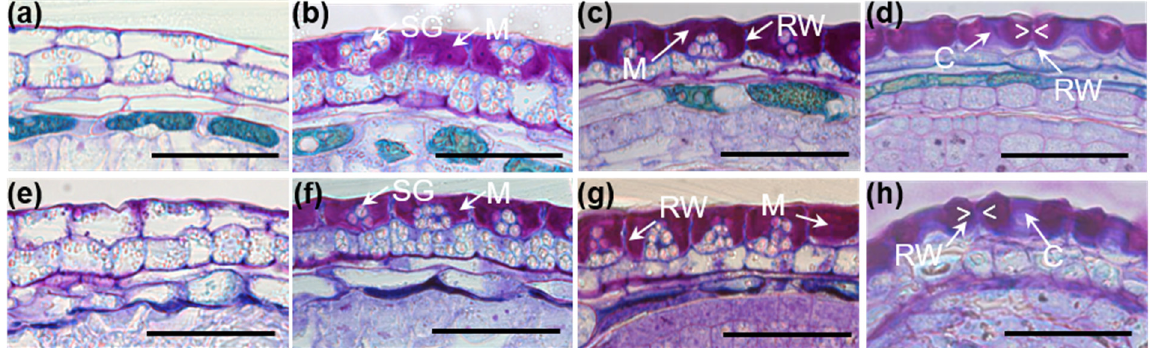
Figure 6. Differentiation of the outer seed coat is delayed in tt15-2 . Sections of developing seeds were stained with toluidine blue O. ( a – d ) wild type Ws-4; ( e – h ) tt15-2. Seeds at 8 DAP ( a ), 10 DAP ( b , e ), 12 DAP ( c , f ) 14 DAP ( d , g ) and 16 DAP ( h ). C, columella; M, mucilage; RW, radial wall; SG, starch granules. Bars: 50 µm.